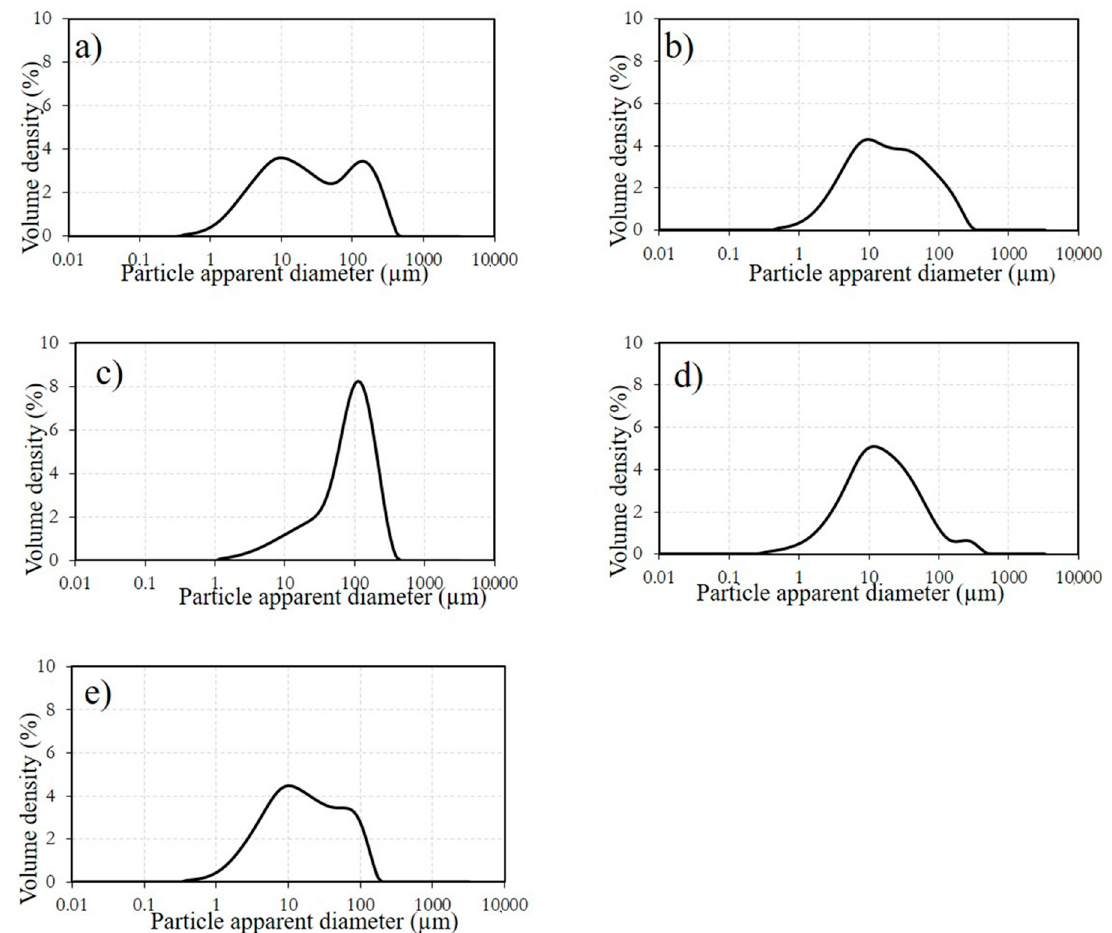
Figure 5. Biochar particles size distribution of ( a ) RH, ( b ) MSP, ( c ) SWP, ( d ) OSR, and ( e ) WSP after grinding.